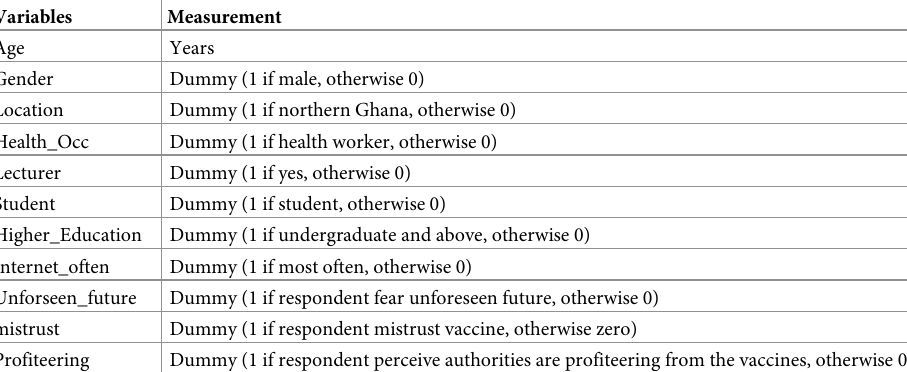
Table 8. Definition of variables and measurement.